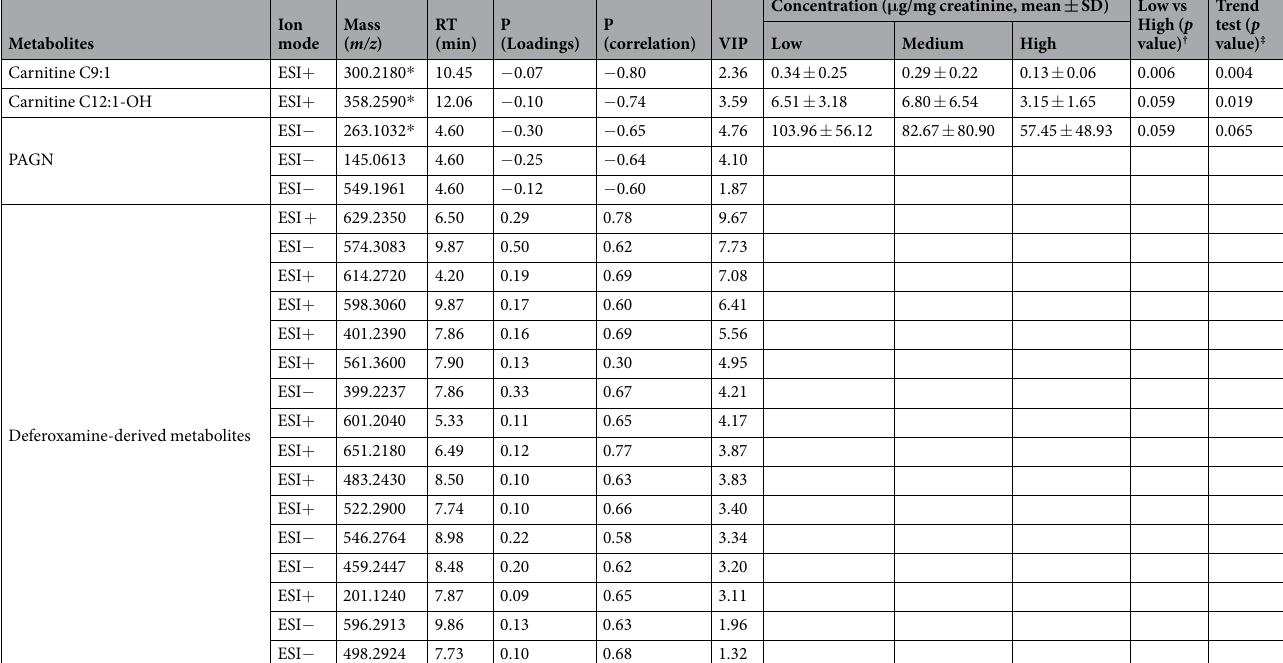
Table 2. Identified metabolites that were significantly different between low- and high-area under the curve (AUC) groups. * Adducts of [M + H] + or [M − H]- for quantification, † Kruskal Wallis test followed by Mann- Whitney test (Significance was adjusted by Bonferroni’s method, P < 0.017), ‡ Jonckheere-Terpstra trend test